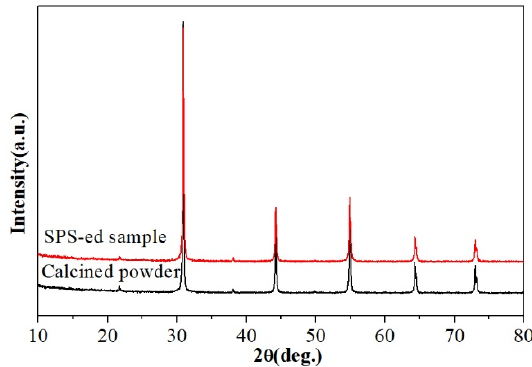
Figure 5. X-ray powder diffraction patterns of the calcined BZT powder and the sintered BZT ceramics by SPS.